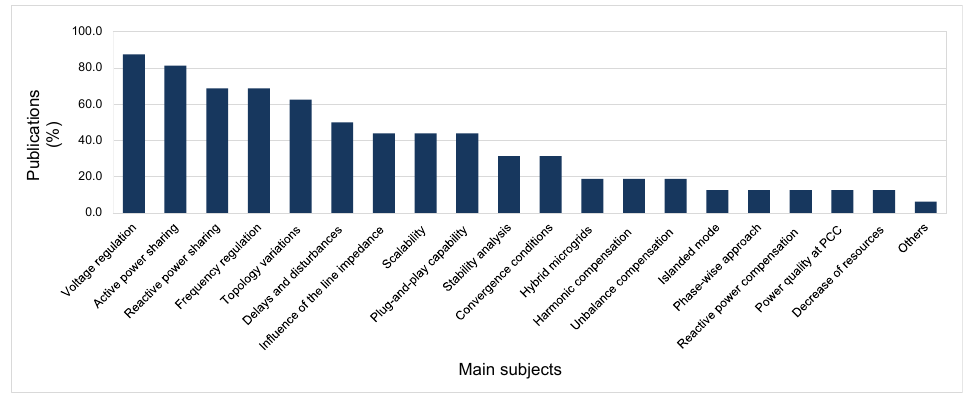
Figure 16. Publications on control systems for MGs—main